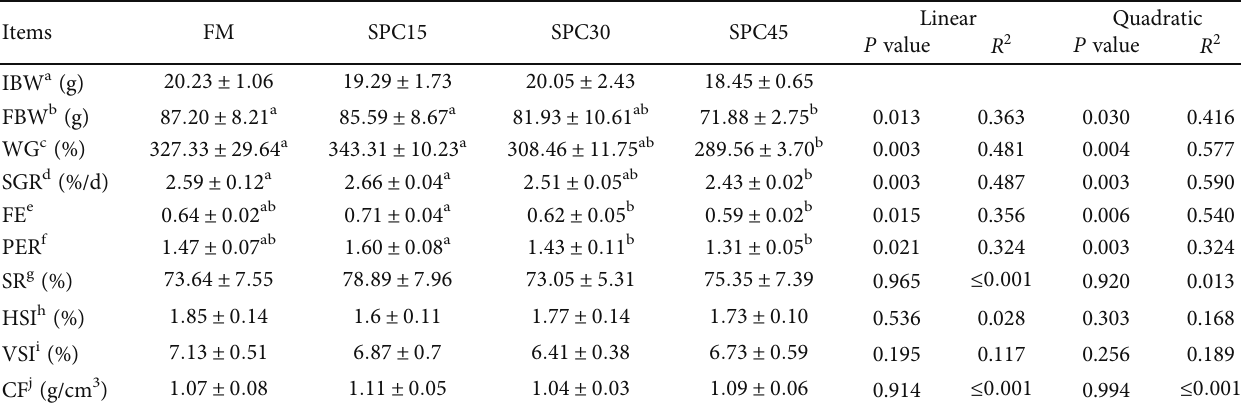
Data in the table are presented as means ± SEM ( n = 4 ). Values in the same raw with di ff erent superscripts are signi fi cantly di ff erent ( P < 0.05). a IBW: initial body weight; b FBW: fi nal body weight; c WG: weightgain ð % Þ = 100 × ð FBW ð g Þ − IBW ð g ÞÞ /FBW ; d SGR: specificgrowthrate ð % /d Þ = 100 × ð ln ð FBW ð g ÞÞ − ln ð